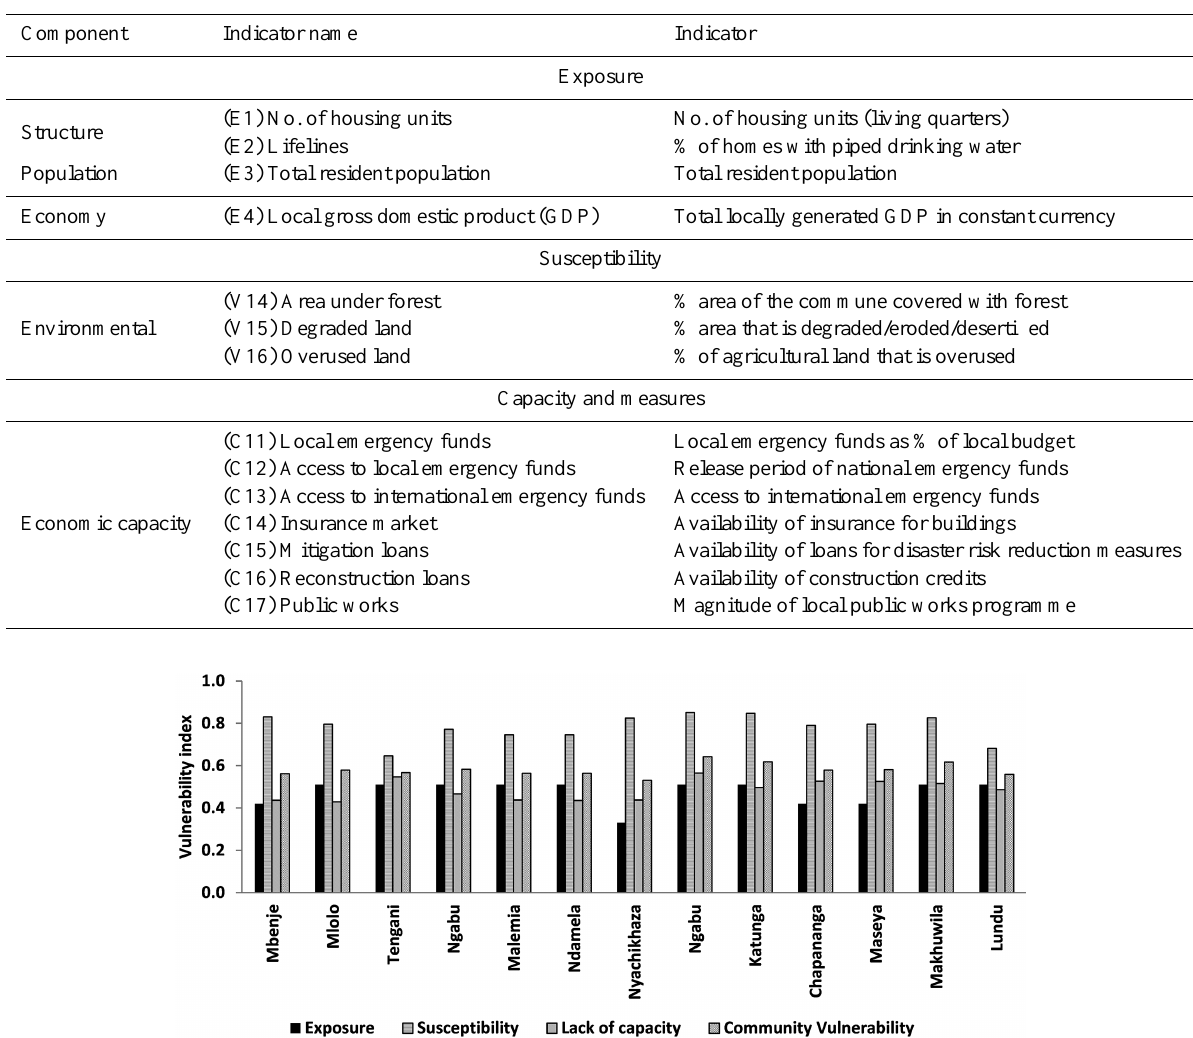
Table 1. Vulnerability factors in the CBDRI.